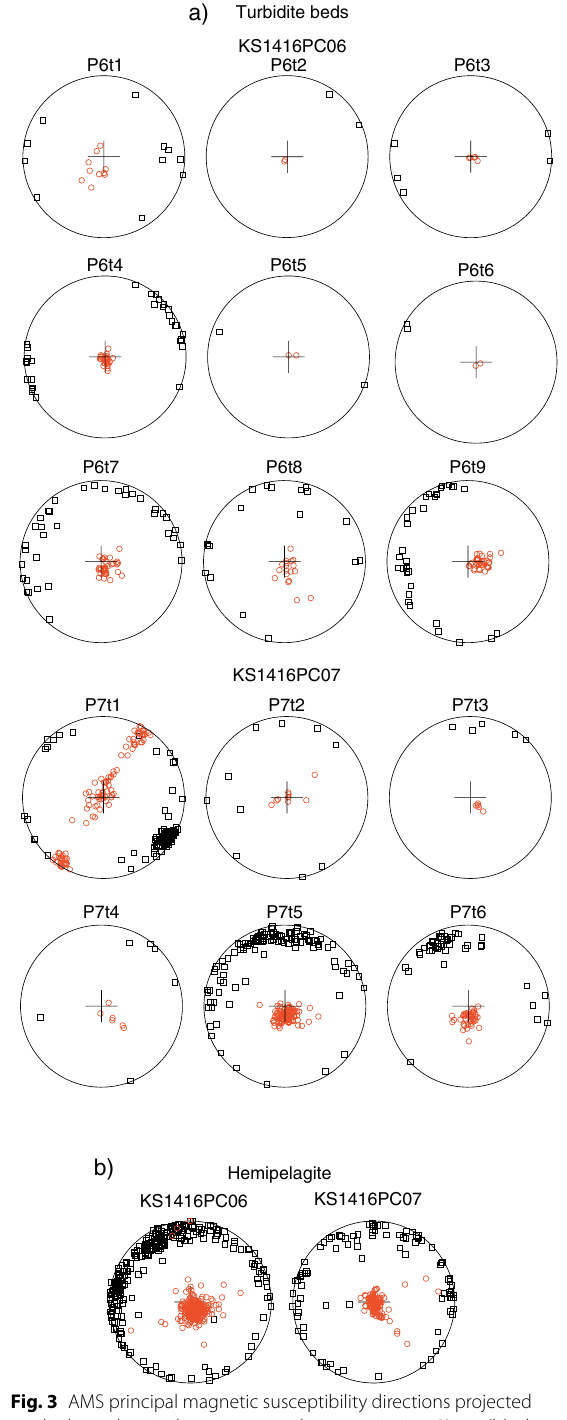
Fig. 3 AMS principal magnetic susceptibility directions projected on the lower hemisphere in an equal‑area projection: Kmax (black open box) and Kmin (red open circle) of a turbidite beds in cores KS1416PC06 and KS1416PC07, and b AMS directions of hemipelagic intervals in cores KS1416PC06 and